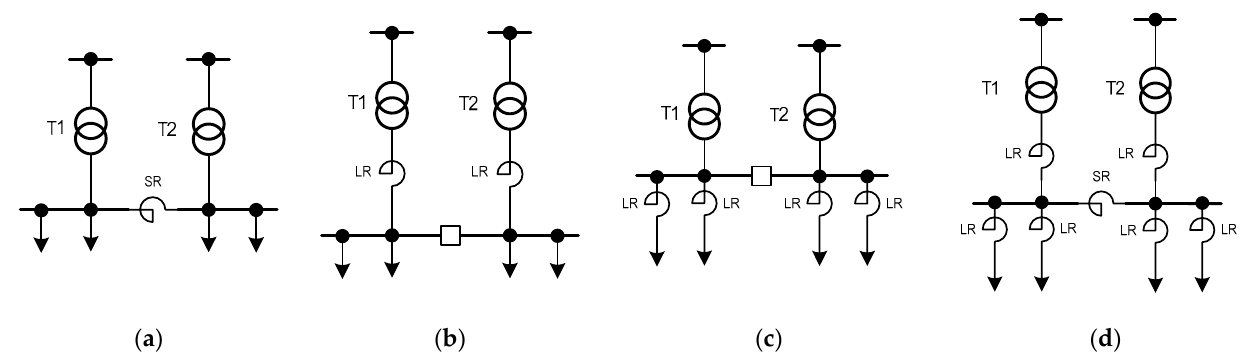
Figure 2. Typical diagrams of air-core current-limiting reactor applications for an MV industrial grid: ( a ) Connection of the bus sections; ( b ) Series connection with the incoming feeder; ( c ) Series connection with the outgoing feeder; ( d ) Mixed type of connection with bus sections and feeders.